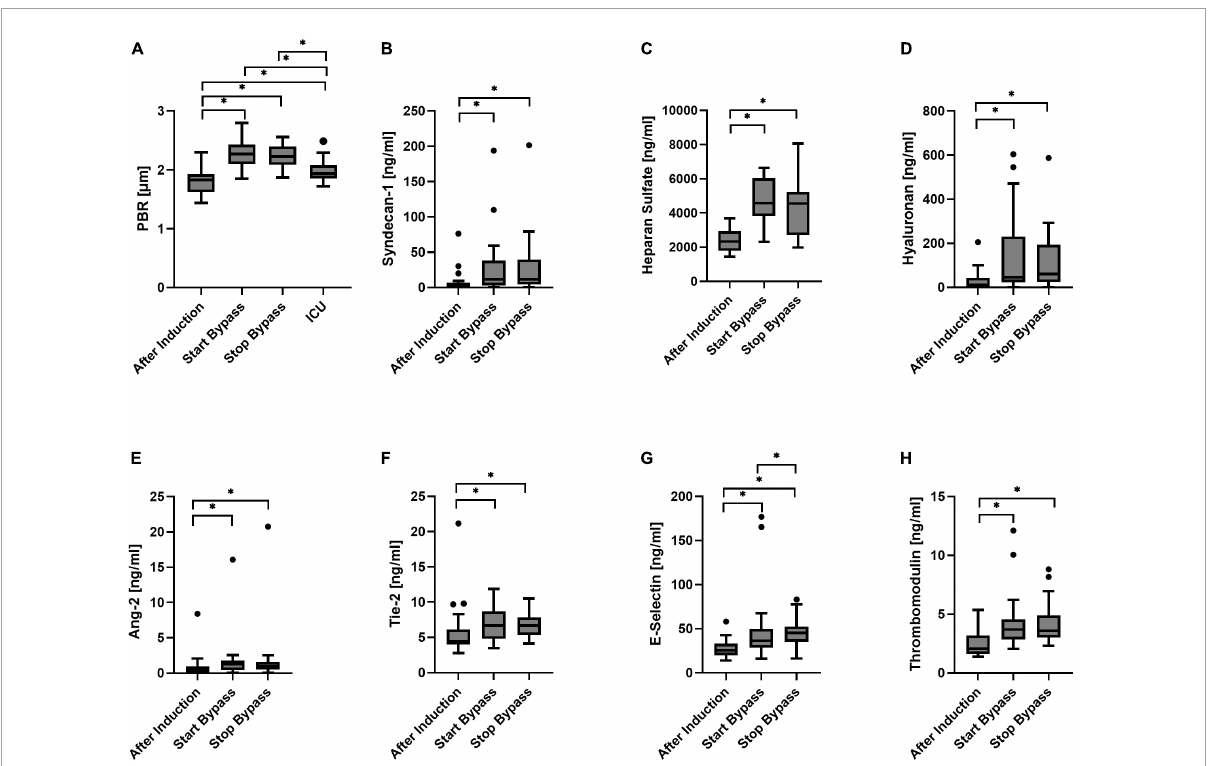
FIGURE3 Boxplot of the perfused boundary region [PBR; (A) ], Syndecan-1 (B) , heparan sulfate (C) , hyaluronan (D) , Angiopoietin-2 [Ang-2, (E) ], Tie-2 (F) , E-selectin (G) , and thrombomodulin (H) for all time points. N = 23 during surgery; N = 19 at ICU. ∗ p <